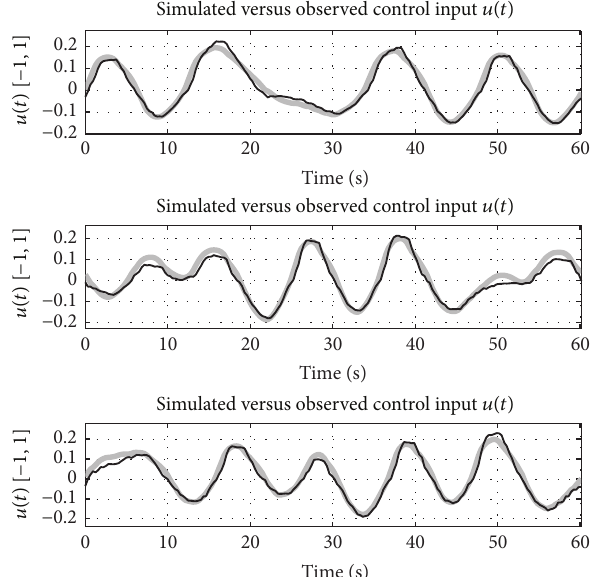
Figure 9: Validation results. The data presents a comparison of the measured control input 𝑢 (grey signal) with the estimation ̂𝑢 (bold signal) found according to the model (44).